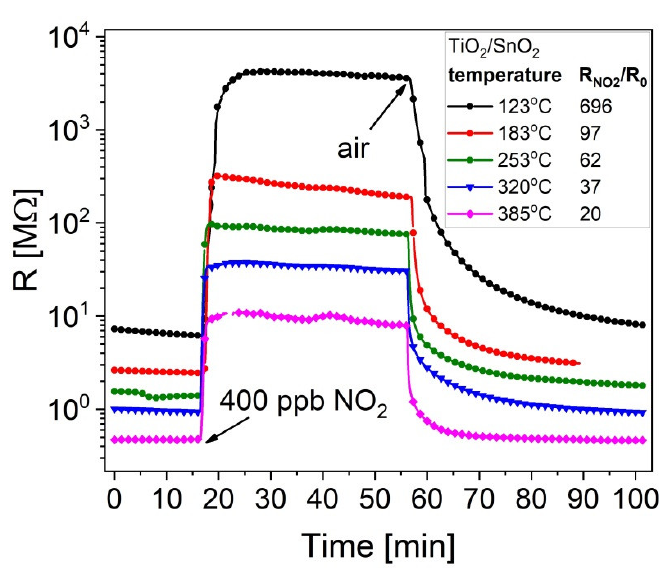
Figure 12. Dynamic changes in the electrical resistance of SnO 2 /TiO 2 thin films at different operating temperatures, upon exposure to 400 ppb NO 2 .